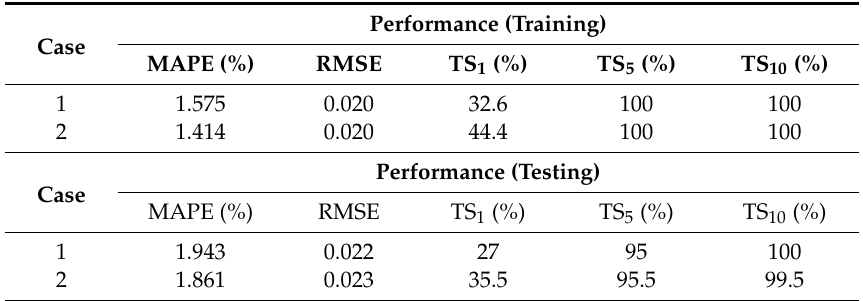
Table 3. Quantitative results in training and testing process using the proposed model.